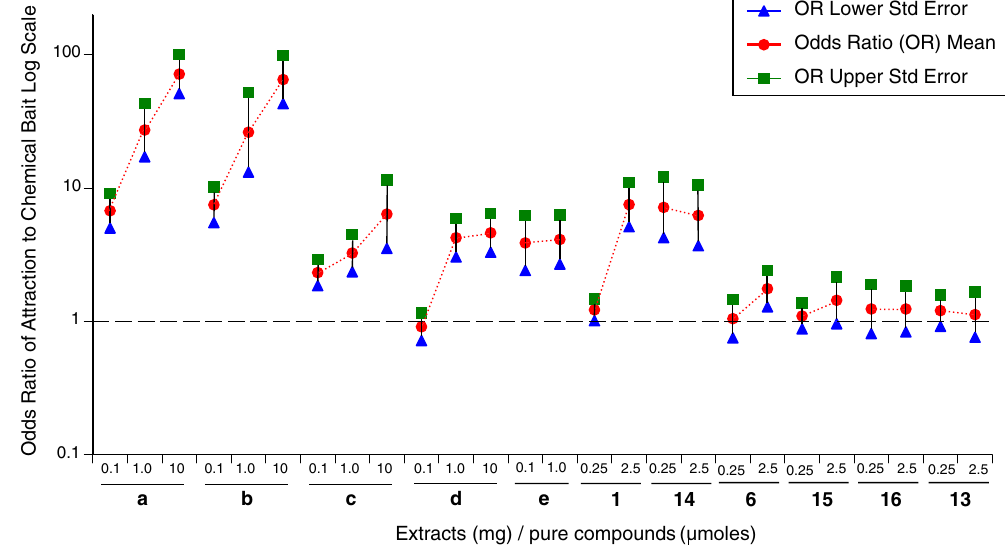
Figure 3. The degree to which cane toad ( Rhinella marina ) tadpoles were attracted to a range of stimuli from conspecifics: ( a ) frozen parotoid gland, ( b ) toad eggs, ( c ) early-development tadpole extracts, ( d ) late- development tadpole extracts, ( e ) fresh parotoid secretion, and pure compounds: ( 1 ) marinobufagin, ( 14 ) digitoxigenin, ( 6 ) marinobufotoxin, ( 15 ) ouabain, ( 16 ) digoxin, ( 13 ) suberoyl-l-arginine, as quantified by the numbers captured in baited versus control traps. Data plotted are the odds of a tadpole selecting a trap baited with chemical compared to a control bait. The dashed horizontal line at odds ratio of attraction at 1 shows the null expectation (no disparity between baited and control traps) if there is no significant attraction. The points show means and standard errors. Treatments with the same chemical composition, differing only in concentration, are linked by dotted